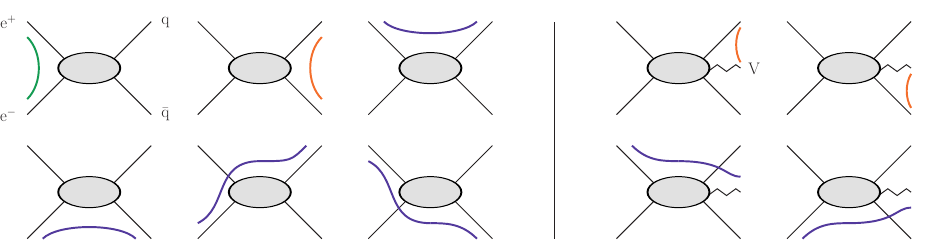
Figure 1: Dipole configurations for e + e − → q¯q states with and without an additional massless vector boson V (i.e. gluon or photon). Green lines indicate dipoles spanned between initial-state particles, red lines dipoles spanned between final-state parti- cles, and blue lines dipoles spanned between one initial and one final-state particle. In the case of QCD, only a small subset of all possible dipoles – the red ones – is em- ployed. Leading-color QCD parton showers would only employ the two red dipoles in the right panel when showering e + e − → q¯qg states, while subleading-color show- ers would retain the red dipole spanned between q and ¯q in the left panel. QED showers will, in general, employ the complete set of dipoles. In this sense, the set of QED dipoles for e + e − → q¯q states is identical to the set of QCD dipoles obtained for q¯q → q (cid:48) ¯q (cid:48) in a fixed-color shower. In the assessment of interferences below, only the configurations from the red dipoles will be used in both the QED and QCD cases, so that a misinterpretation of results based on different phase space coverage of the QCD and QED showers can be